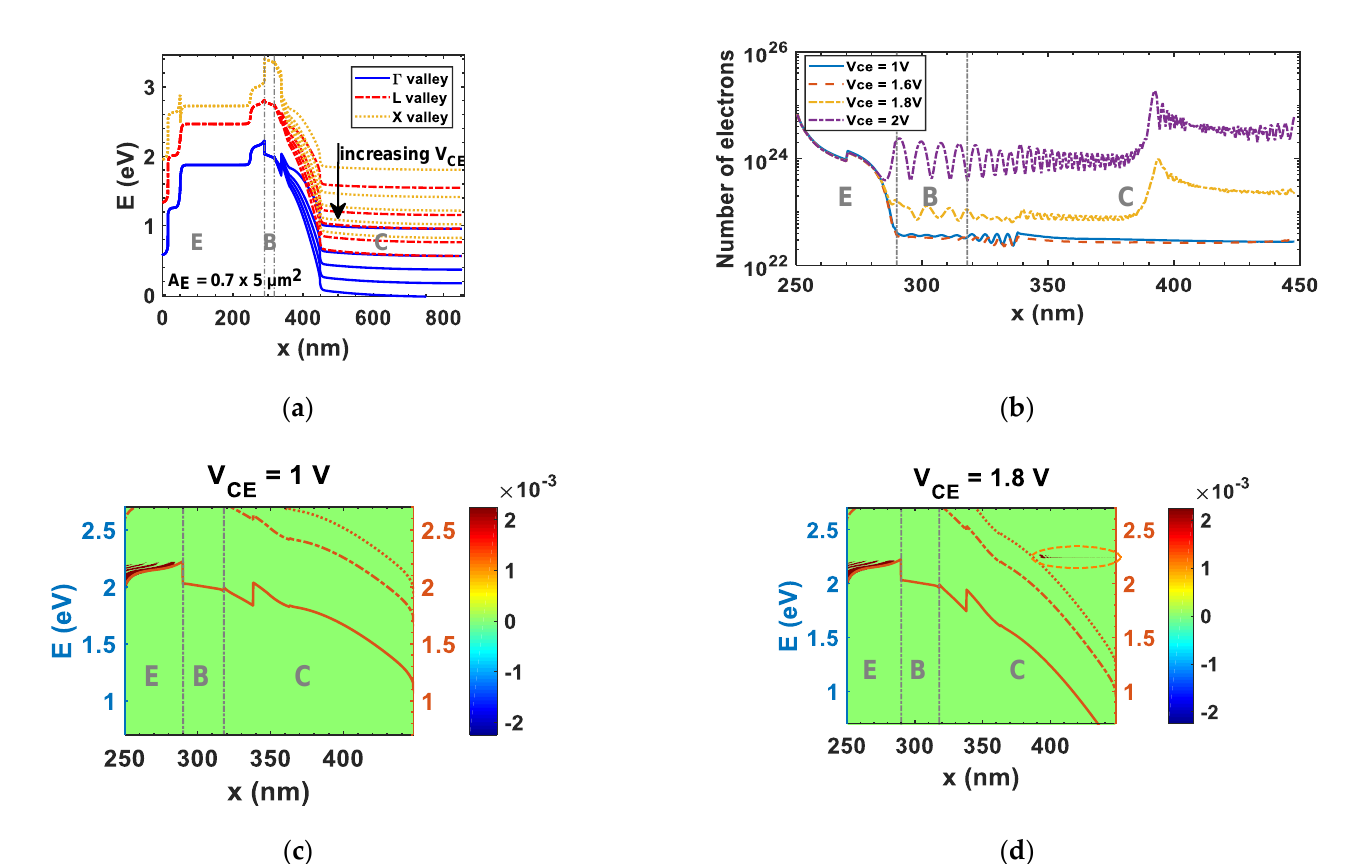
Figure 20. ( a ) Simulated bulk bandstructure of In 0.53 Ga 0.47 As; ( b ) energy level of the different valleys of In x Ga 1-x As as a function of x [30].